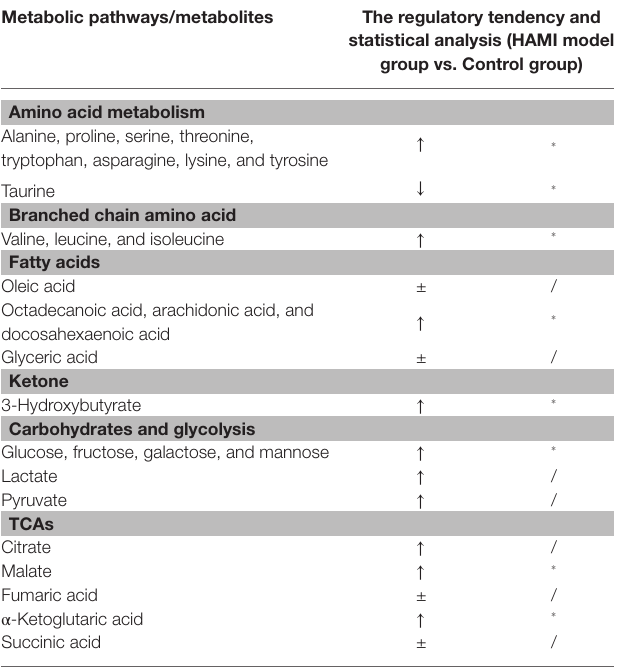
TABLE 1 | The perturbed cardiac tissue metabolites induced by high-altitude hypoxia on the metabolites. Metabolic pathways/metabolites The regulatory tendency and statistical analysis (HAMI model group vs. Control